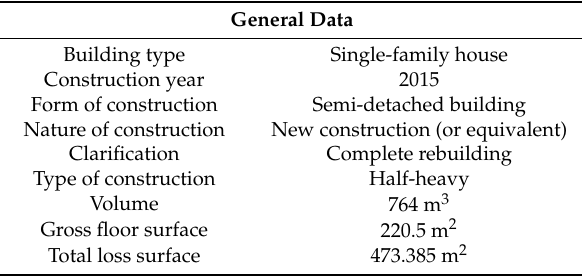
Table 5. Extracted general data out of EPC